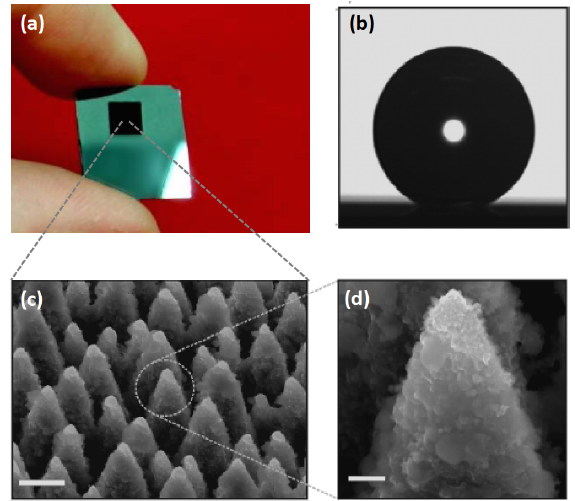
Figure 4: (a) Photograph of a black Si area where a Si substrate was textured using a femtosecond laser in a halogen